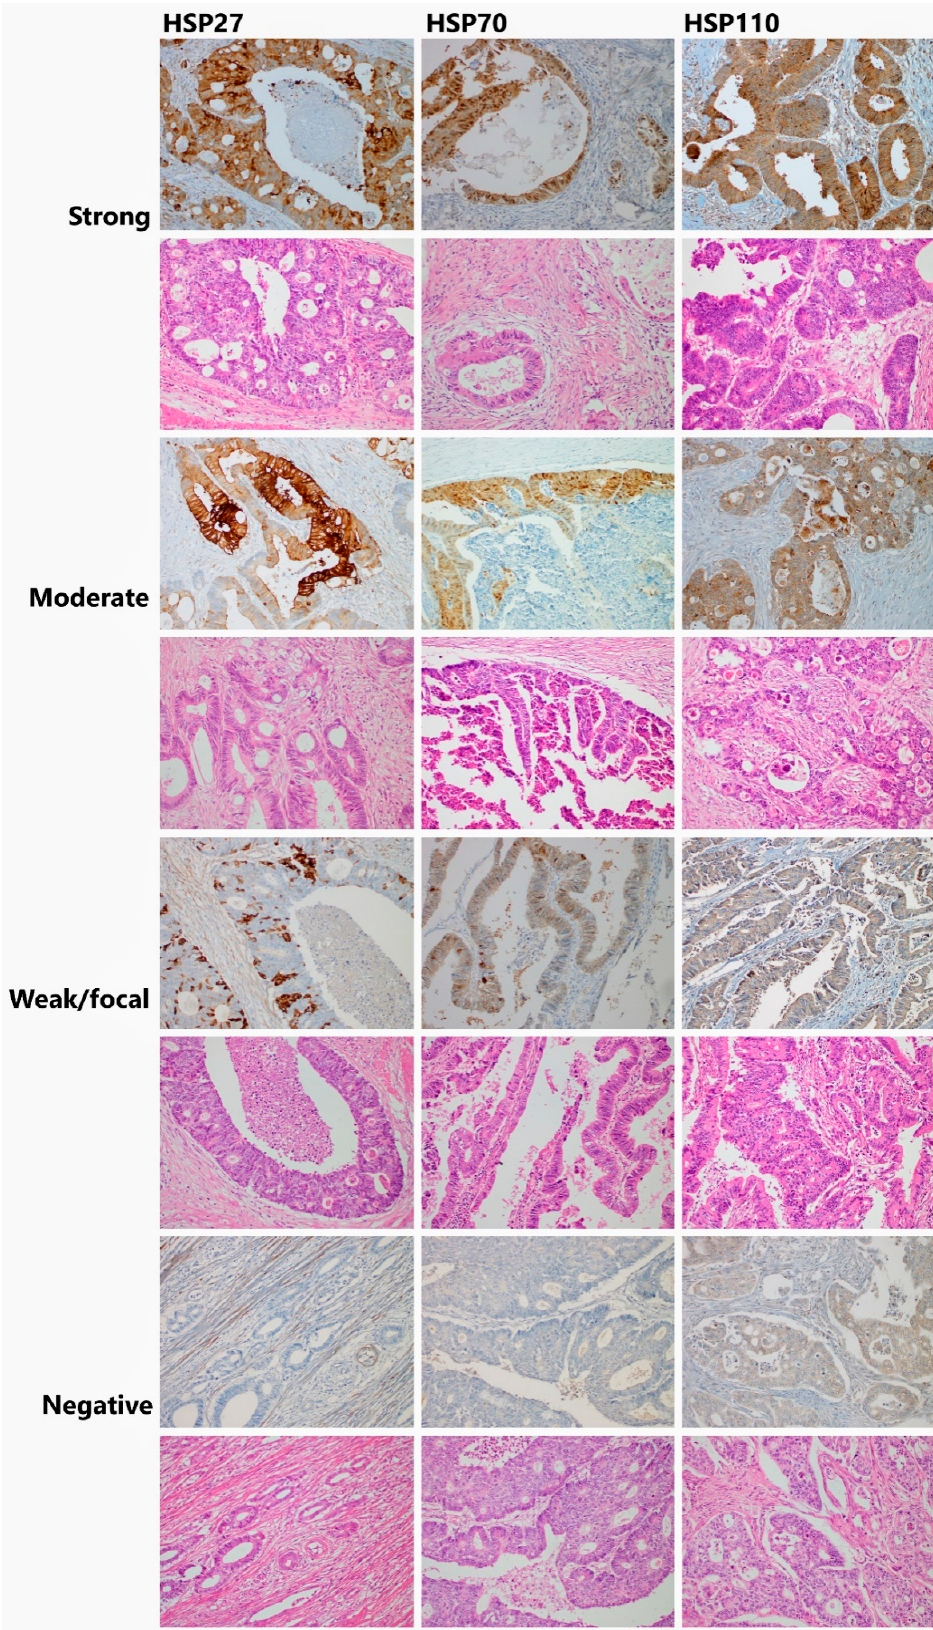
Figure 1. Histological images showing various conventional colorectal adenocarcinomas with different heat shock protein (HSP) staining intensity in immunohistochemistry.